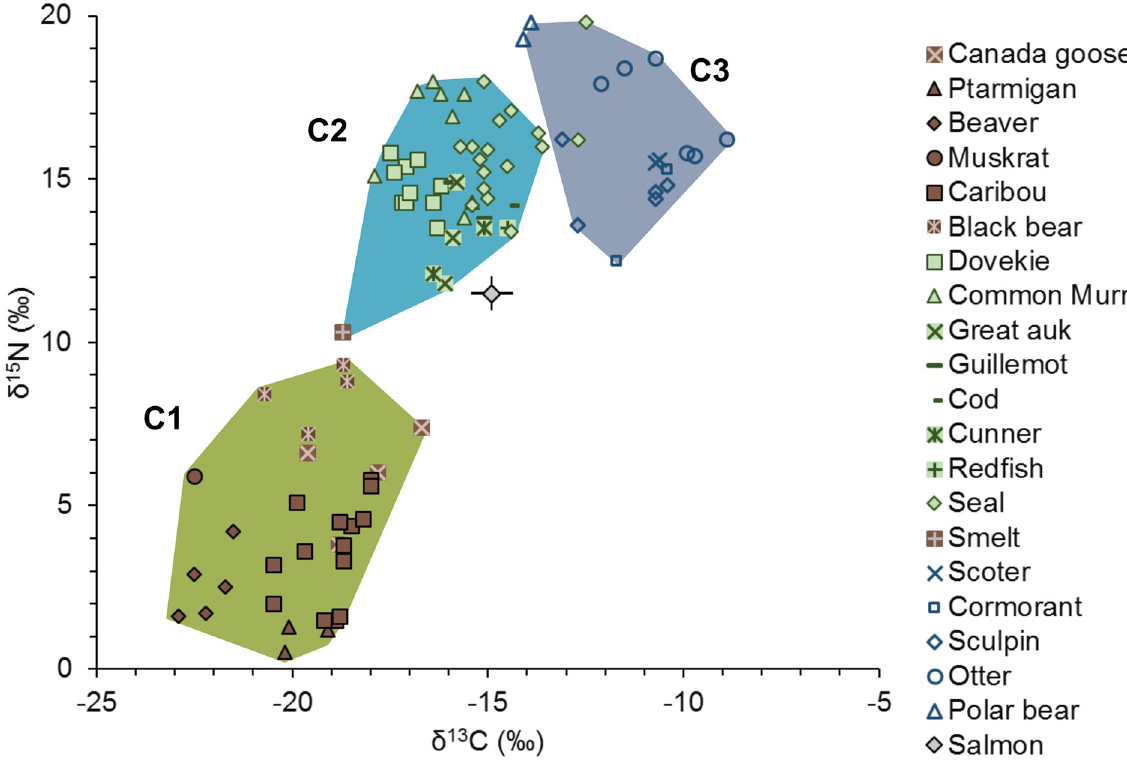
Fig 6. Clusters of archaeological fauna used in the SIAR model. The modern Newfoundland salmon data are from Dixon et al. 2012, and are corrected for the Suess Effect.